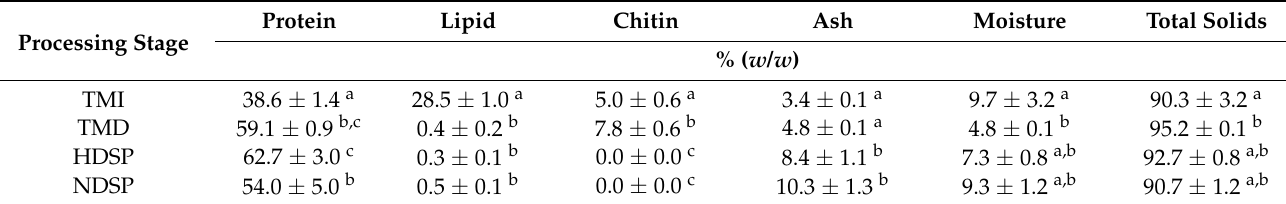
Table 1. Proximate composition of T. molitor fractions at different processing stages expressed on a dry basis. Processing